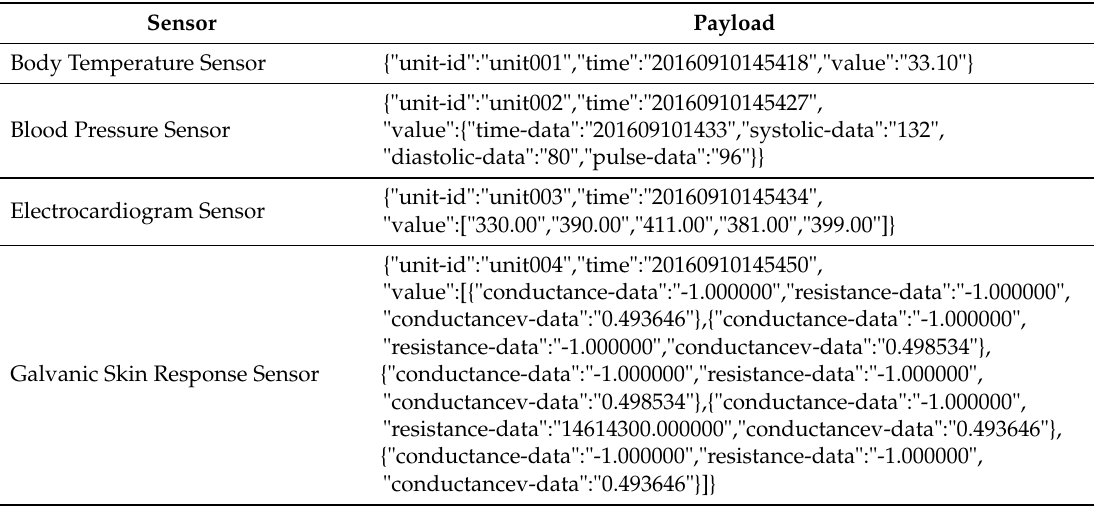
Table 4. Request message